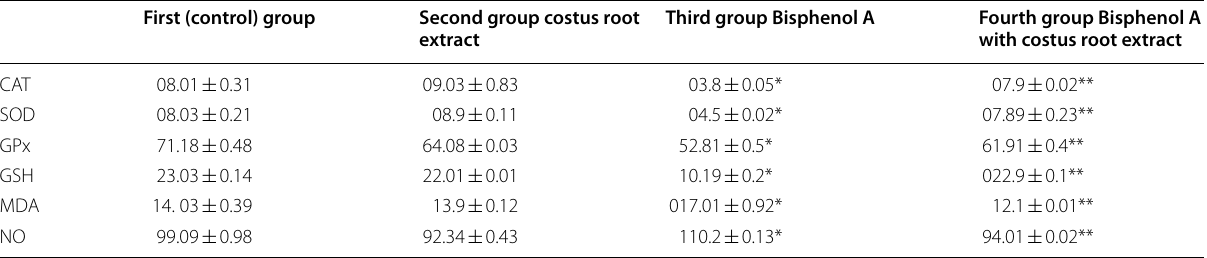
Table 2 Effect of the administration of Bisphenol A itself or together with costus root extract on antioxidant enzymes of testis CAT, GPx, SOD, GSH, MDA, and NO